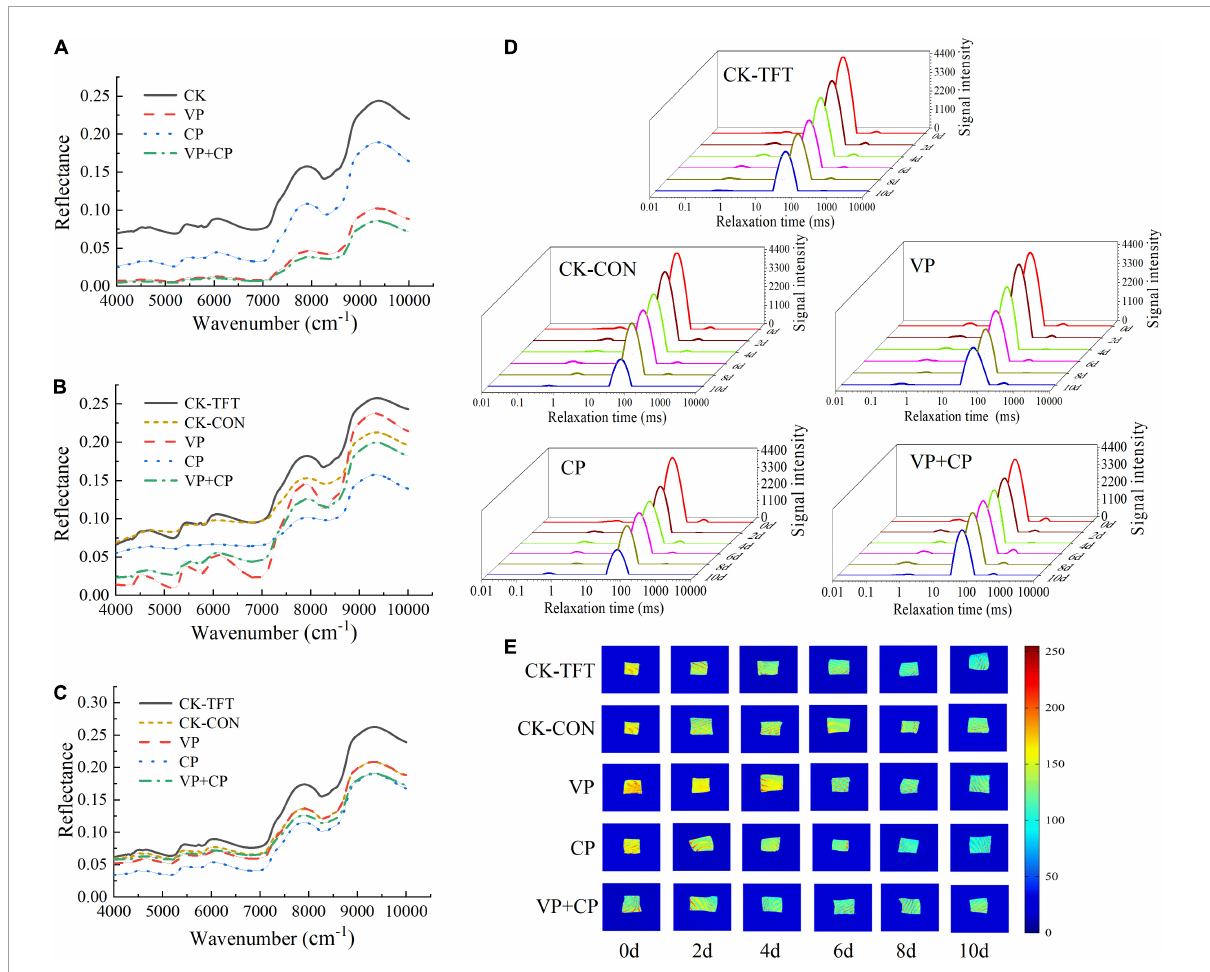
FIGURE3 Original reflectance spectra of salmon treated by curcumin and piperine combined with vacuum packaging on day 0 (A) , day 4 (B) , and day 10 (C) ; typical LF NMR T 2 relaxation times (D) and MRI (E) of salmon treated by curcumin and piperine combined with vacuum packaging during cold chain